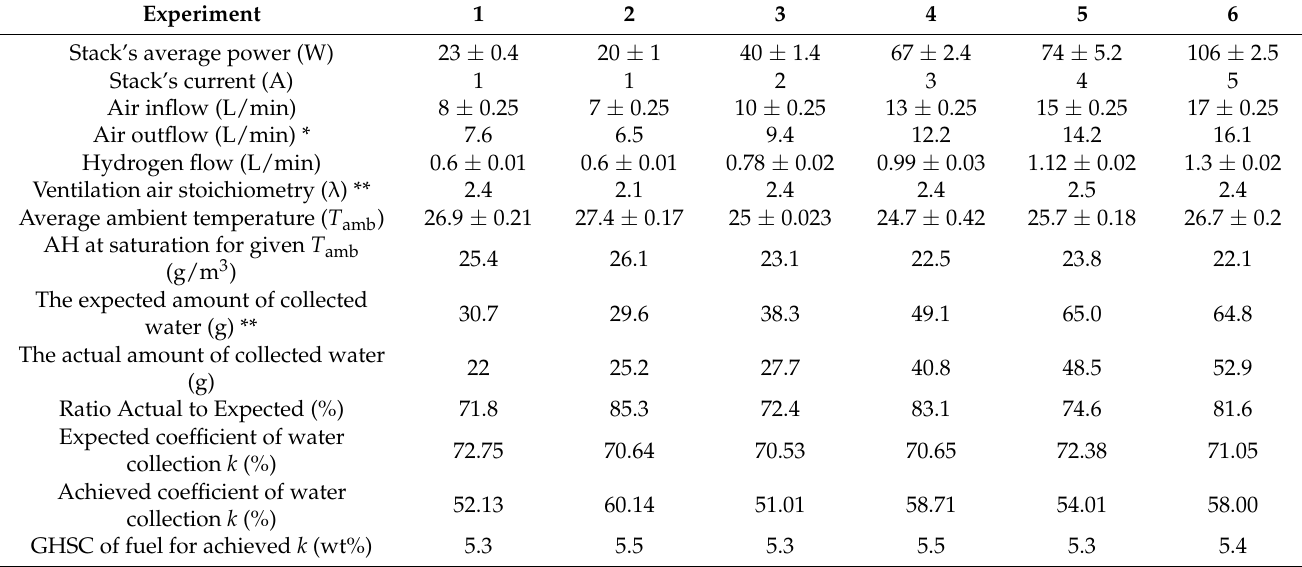
Table 1. Details of the experiments data and